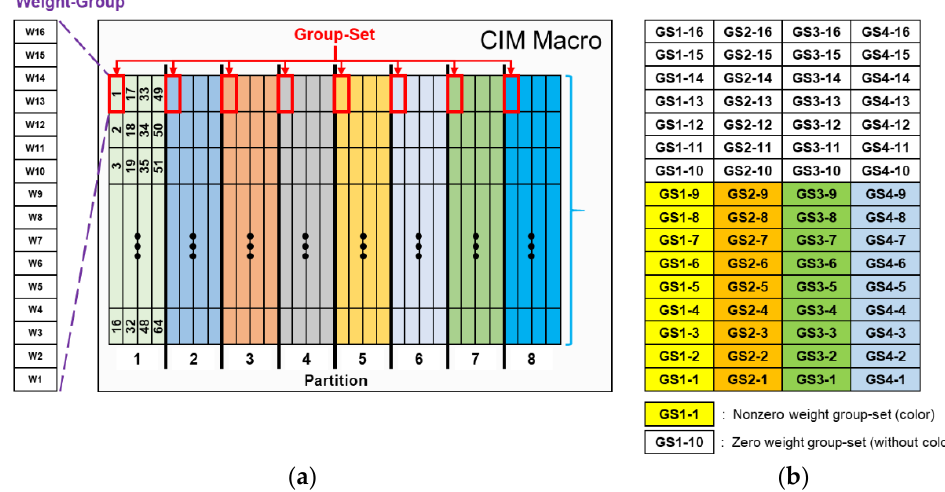
Figure 5. ( a ) SRAM CIM macro partitions. ( b ) Weight mapping in one partition of the CIM, showing the mapping situation that contains both zero and non-zero weight groups of the CIM.